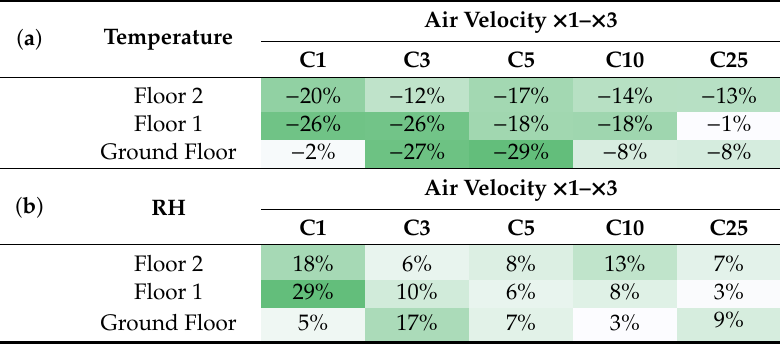
Table 4. Temperature and Relative Humidity with variation of air velocity. Darker colour indicates the higher values.